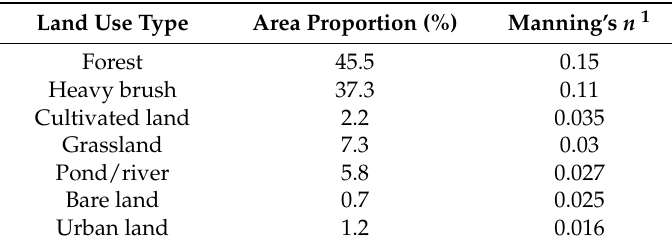
Table 1. The area proportion and Manning’s n of different land use types in the Misai